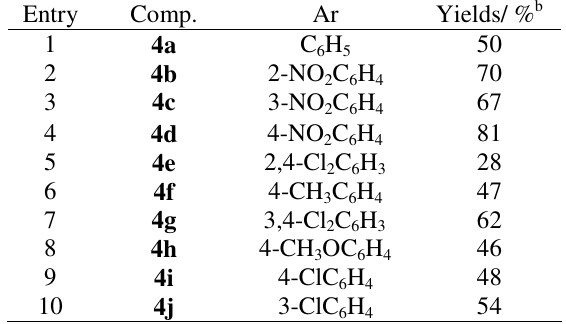
Table 1. Synthesis of compound 4 in aqueous media under 90 o C catalyze by SDS. Entry Comp. Ar Yields/ %